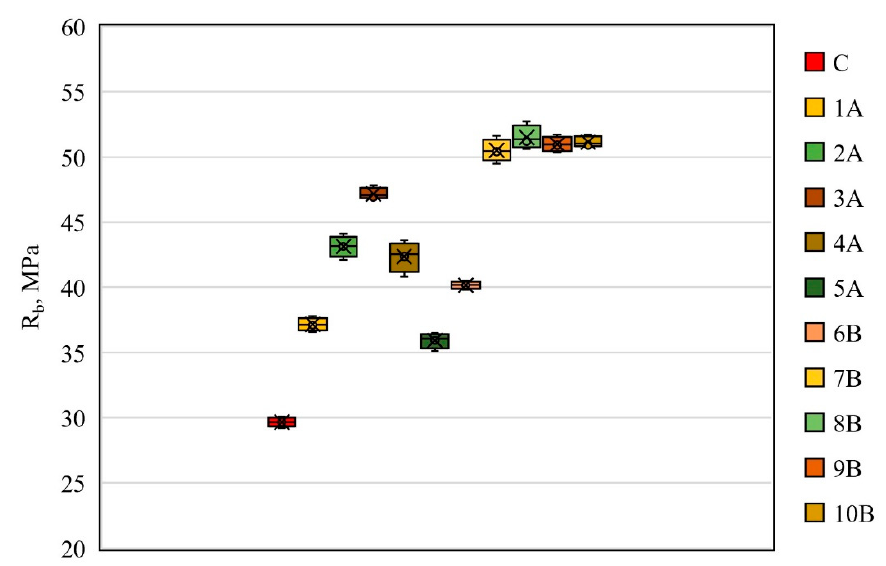
Figure 10. Strength of sample cubes after water saturation.